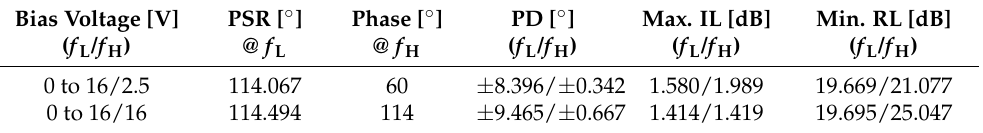
Table 4. Measured results of the dual-band PS achieved by varying the bias voltage of the low-band while fixing the bias voltage of the